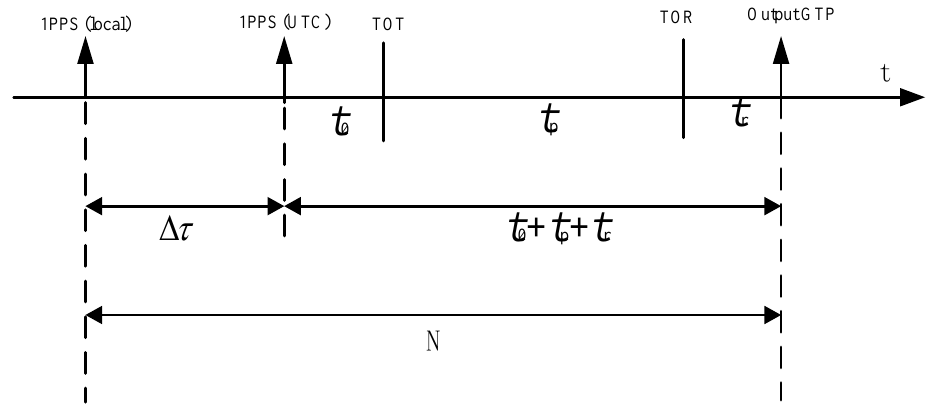
Figure 2. Principle of eLoran autonomous timing.